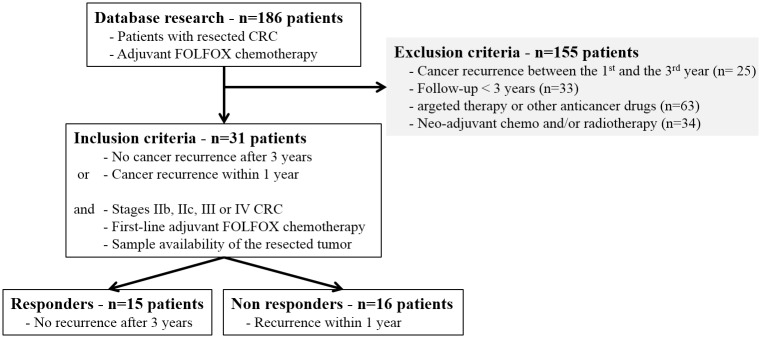
Flow Chart of patient selection.Patients were identified and selected from the database of the Digestive Surgery Unit between 2006 and 2013.